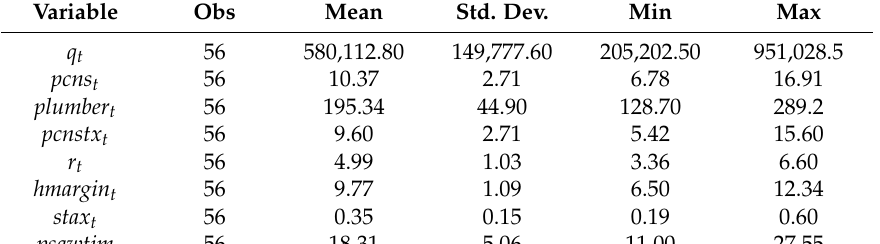
Table 2. Summary of data used in empirical estimation: 2003 Q1–2016 Q4 (price series are in $1982).